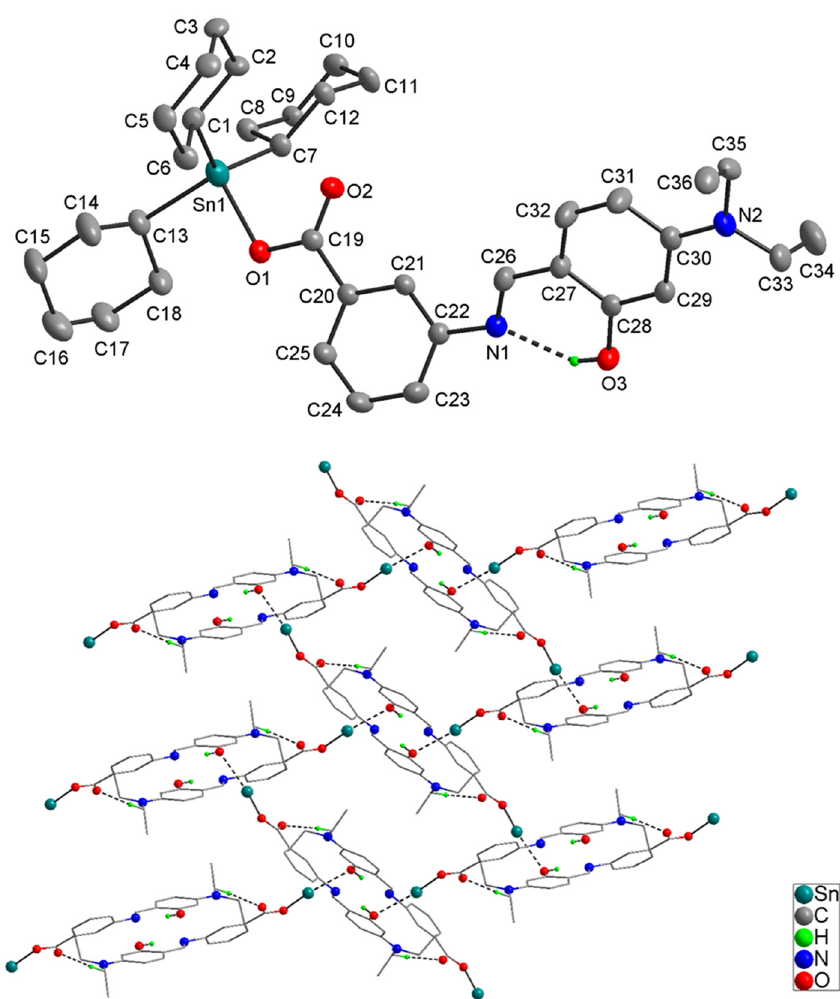
Figure 3: ( Top ) The molecular structure of 3. Ellipsoids are drawn at 30% probability level. Hydrogen atoms are omitted for clarity except H 3 atoms. ( Bottom ) Two - dimensional supramolecular network formed by the intermolecular Sn ⋯ O interactions and C – H ⋯ O hydrogen bonds. The Cy groups bonded to Sn are omitted for